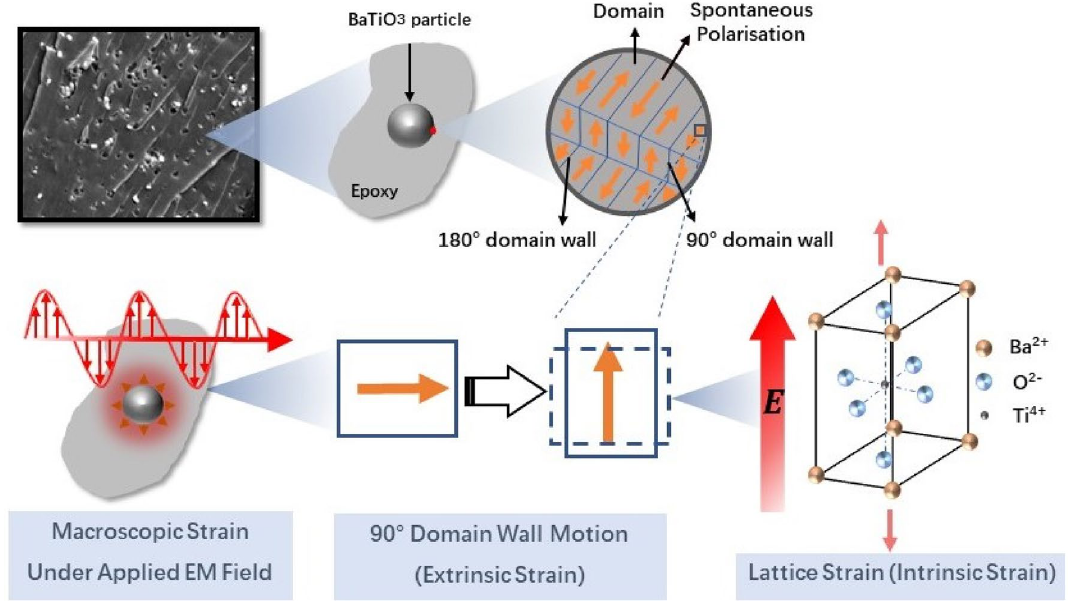
Figure 1. Schematic diagram of the extrinsic strain and intrinsic strain that contributes to macroscopic strain in a tetragonal BaTiO 3 crystal embedded in epoxy (red, green and blue arrows represent electric field induced intrinsic strain, extrinsic strain and macroscopic strain,